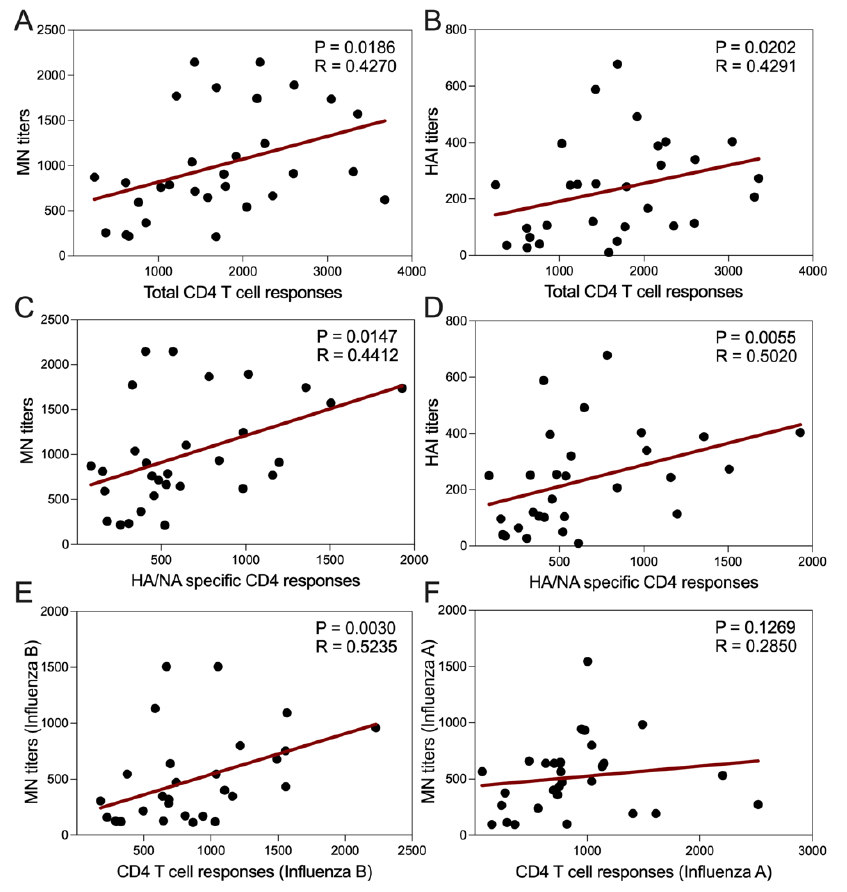
Figure 5. Correlation between cellular and humoral immune responses. ( A , B ) Total antibody titers for all 4 strains of influenza viruses measured by both microneutralization (MN) and hemagglutination inhibition (HAI) assays shown positive correlation with total CD4 T cell responses, which were measured by the number of influenza virus reactive cytokine producing CD154+ CD4 T cells per million of total CD4 T cells. ( C , D ) Total MN and HAI titers correlated with HA/NA specific CD4 responses better. ( E , F ) Influenza B specific MN titers correlated with Influenza B specific CD4 responses, however Influenza A specific MN titers did not correlate well with Influenza A specific CD4 responses. ( A – F ) Data from all 3 visits of 10 study subjects were included and correlation were calculated by Spearman correlation test. p values < 0.05 were considered statistically signifi- cant.